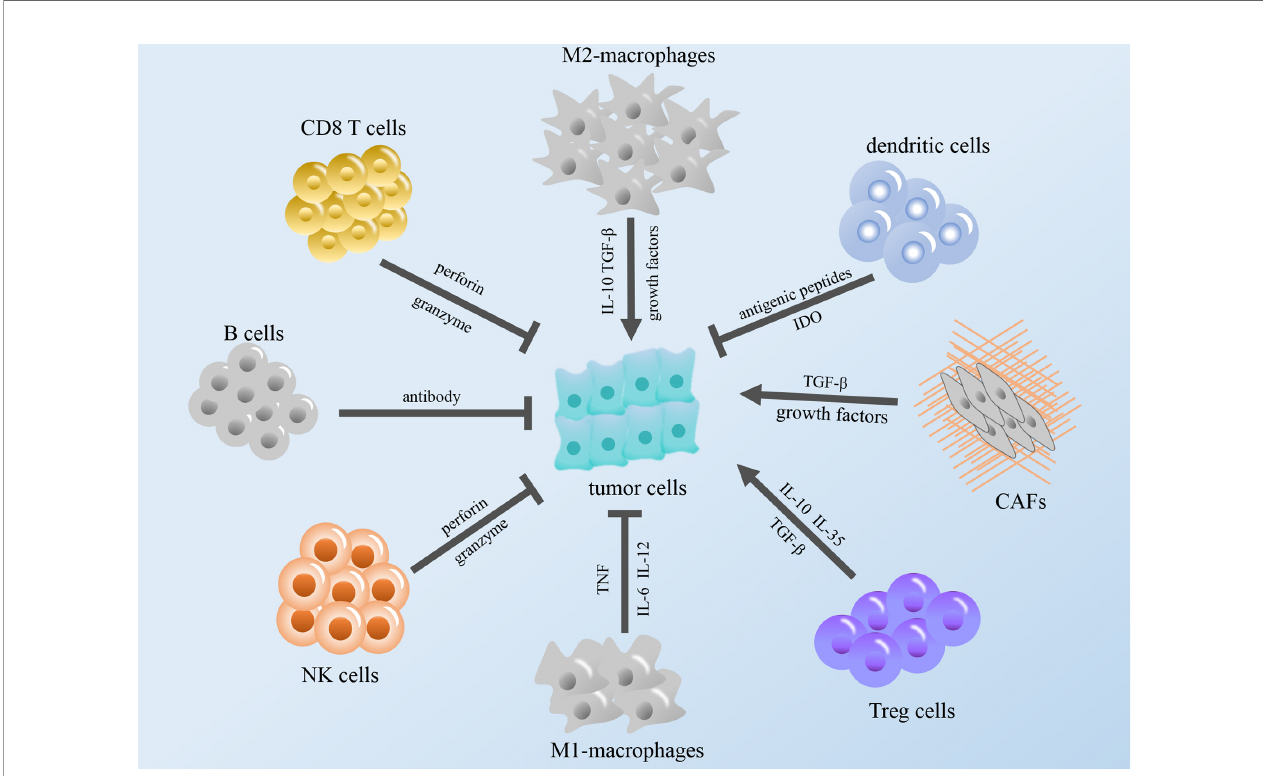
FIGURE 1 | Modulation of the tumor immune microenvironment. The fi gure shows that immune cells in TME regulate tumor growth through cytokines and other regulatory factors. TGF- b , transforming growth factor b ; IL, interleukin; NK cells, natural killer cells; TNF, tumor necrosis factor; IDO, indoleamine 2,3-dioxygenase; CAFs, cancer-associated fi broblasts; Treg cells, regulatory T